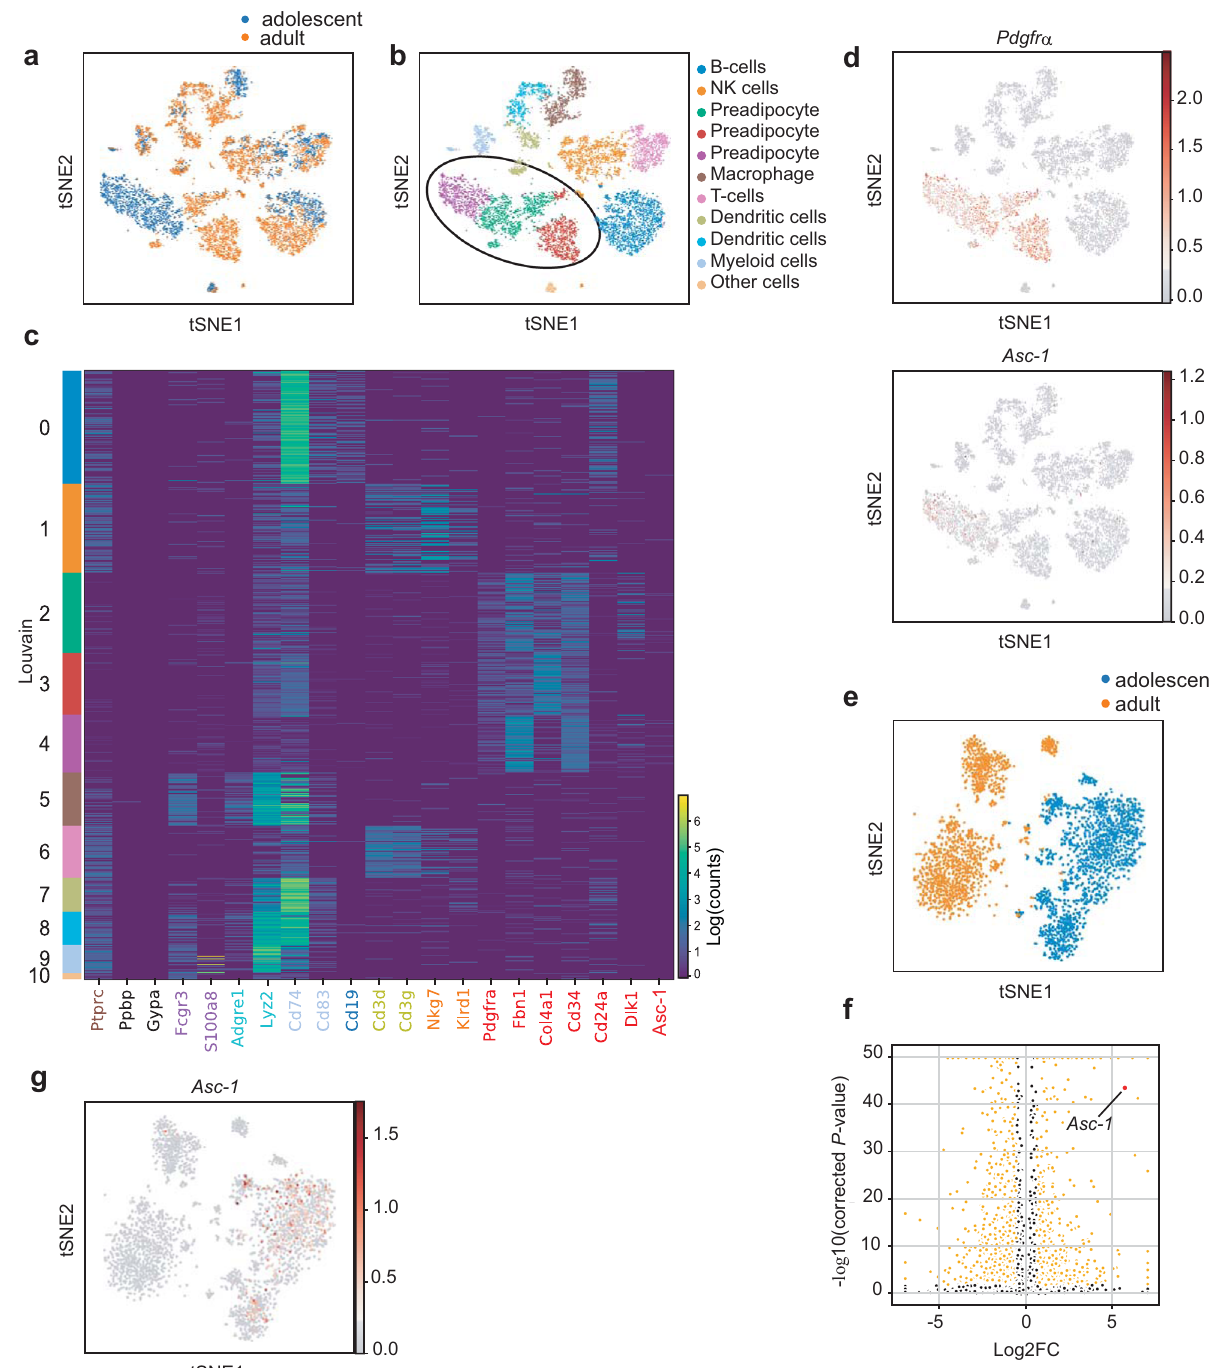
Fig. 1 Single-cell sequencing reveals major differences between adolescent and adult preadipocytes. Single-cell sequencing of cells of the subcutaneous stromal vascular fraction from 2- to 8-week-old male C57Bl/6 mice. Cells were pooled from the SCF of seven (2 weeks old) and fi ve (8 weeks old) mice. T - stochastic neighborhood embedding ( t -SNE) of union of adolescent and adult cells of the SCF SVF ( n = 9344) with mouse age ( a ) and Louvain group ( b ) superimposed. The circle indicates clusters containing preadipocytes. c Log1p expression [log1p = log( X + 1), where X is the expression of gene of interest in particular cell. Note that X , the mRNA counts from the alignment, are integer numbers] of different cell type markers in the 11 louvain clusters by cell ( n 0 = 1733, n = 1379, n = 1222, n = 948, n = 892, n = 816, n = 799, n = 518, n = 514, n = 421, n = 102). Leukocytes ( Ptprc ), T cells ( CD3d , CD3g ), NK 1 2 3 4 5 6 7 8 9 10 cells ( Nkg7 , Klrd1 ), myeloid cells ( Fcgr3 , S100a8 ), macrophages ( Adgre1 , Lyz2 ), dendritic cells ( CD74 , CD83 ), B cells ( CD19 ), megakaryocytes ( Ppbp ), erythrocytes ( Gypa ), and preadipocytes ( Pdgfra , Fbn1 , Col4a1 , CD34 , CD24a , Dlk1 , Asc-1 ). d t -SNE of union of adolescent and adult cells of the SCF SVF ( n = 9344) with log1p Pdgfra and Asc-1 expression superimposed. e t -SNE of preadipocytes from adolescent and adult SCF ( n = 3,062) colored by age. f Volcano plot of comparison between adolescent and adult preadipocytes with differential expression (false discovery rate-corrected P value <0.01, Welch ’ s t test) indicated by log1p expression. Each dot is a gene. Black: not differentially expressed, yellow: differentially expressed, red: Asc-1. g t -SNE of preadipocytes from adolescent and adult SCF ( n = 3062) colored by Asc-1